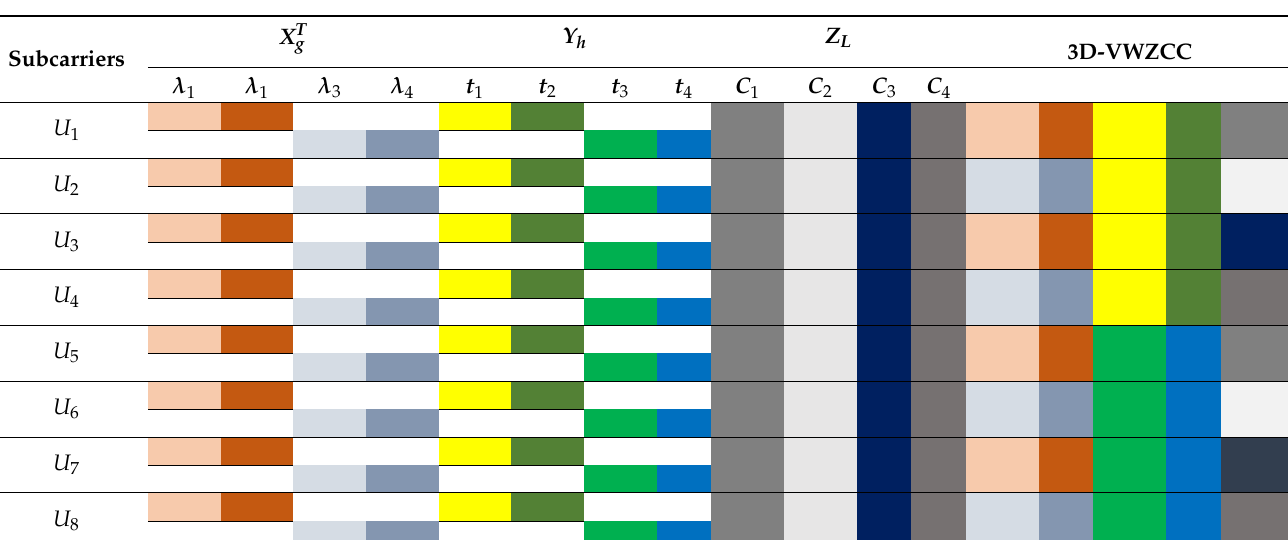
Table 7. Implemented code words for network